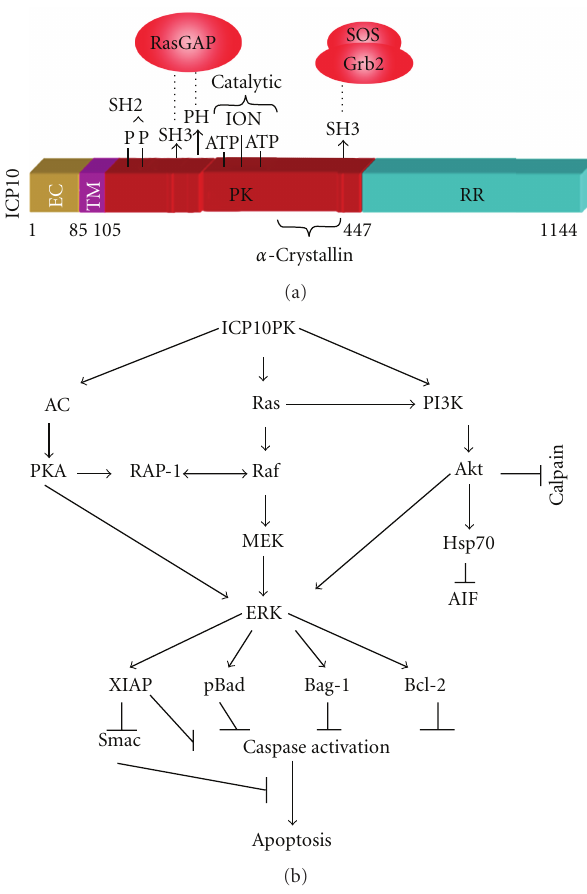
Figure 1: ICP10PK activates survival/proliferative pathways that initiate with Ras activation. (a) Schematic representation of the ICP10PK functional motifs. Shown are the binding sites for the Grb2-Sos complex and Ras-GAP, the PK catalytic motifs the TM and extracellular (EC) domains, and the α -crystallin domain. (b) The activated signaling pathways include the Ras/c-Raf/MEK/ERK, the PI3-K/Akt, and the AC/PKA. The pathways converge on ERK activation and modulate apoptosis regulatory proteins that control caspase activation (Bcl2 family) and caspase activity (iAP family) and their inhibitors (Smac). ICP10PK also inhibits calpain activation and AIF release. Ras activation is through recruitment of the GEF Sos and inhibition of the Ras-GAP through direct phosphorylation